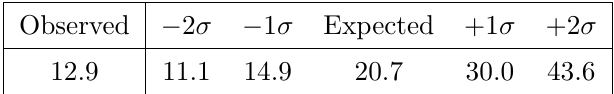
95% CL exclusion limits for SM non-resonant HH production, in units of the SM prediction for (cid:27) ( pp ! HH ! b (cid:22) bb (cid:22) b